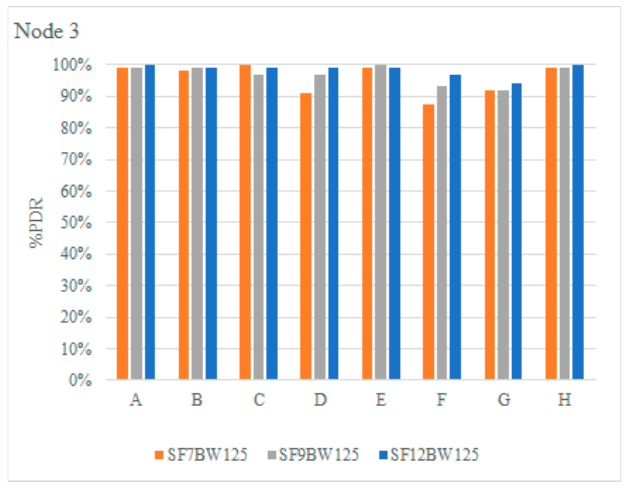
Figure 12. PDR Nodes 3.